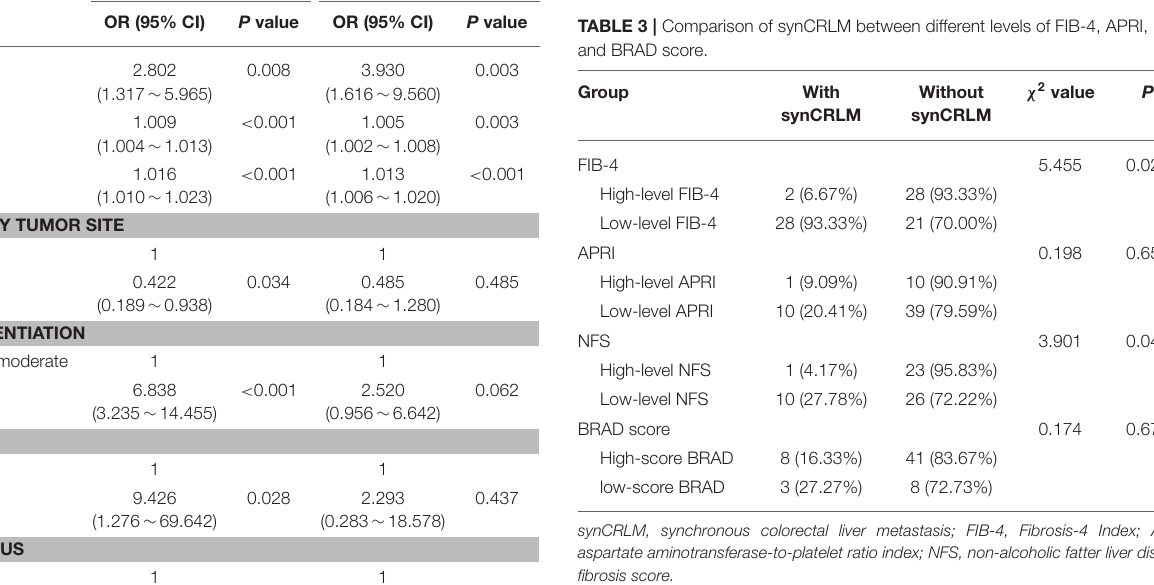
TABLE 2 | Univariate and multivariate logistic regression analysis of the significant predictors for synchronous colorectal liver metastasis. Variables Univariate analysis Multivariate analysis